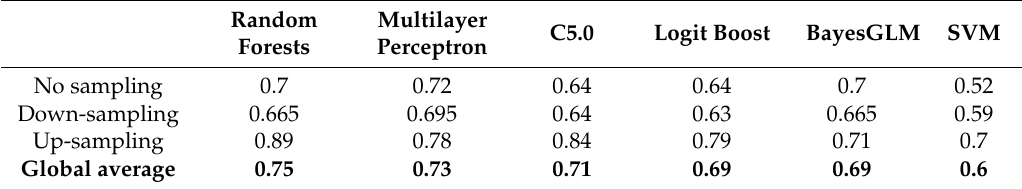
Figure 3. Highest mean accuracy values in up-sampling subset, corresponding to each ML method. Each color bar represents the di ff erent classification models. The texture of the bar represents the input predictor from which each model has been generated. The three di ff erent up-sampling methods are represented grouped in the X axis. Table 1. Mean accuracy values for the di ff erent sampling subsets, corresponding to each ML method. ML tools are shown from left to right according to higher values of the global average